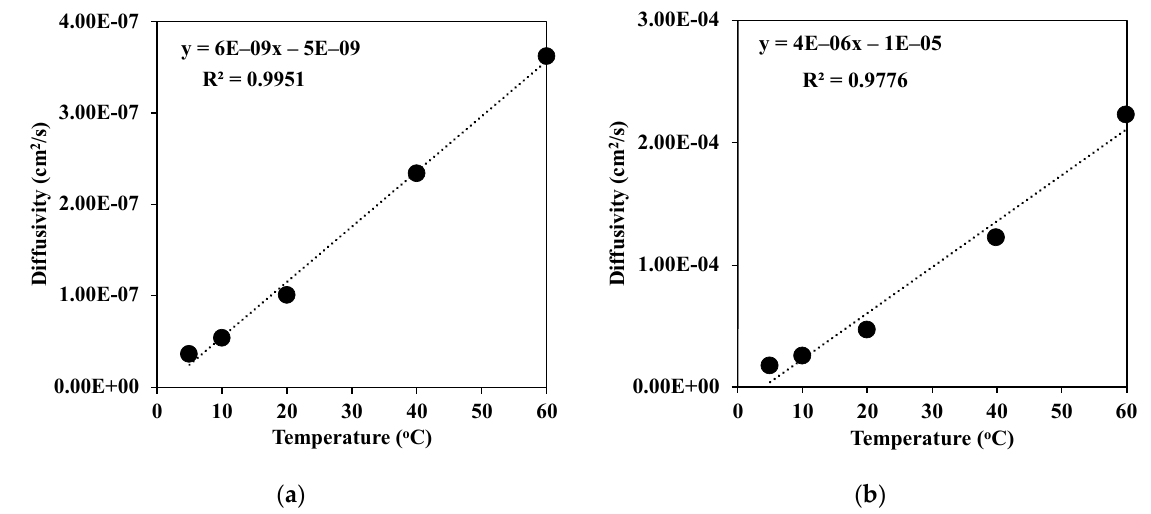
Figure 5. Diffusivities of ( a ) water in DMAc and ( b ) DMAc in water at different temperatures of the coagulation bath.